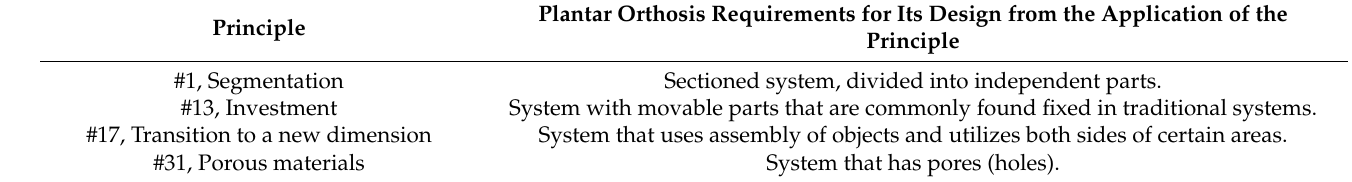
Table 2. General system